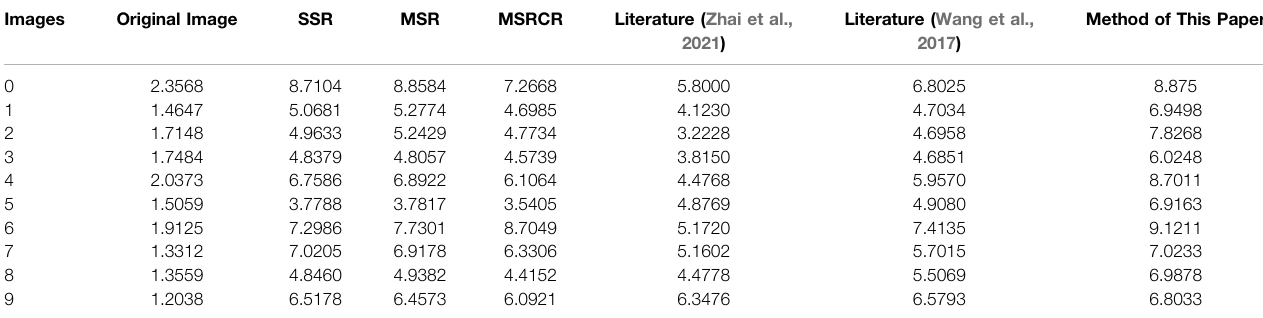
TABLE 5 | AG of low-illumination image enhancement with different algorithms. Images Original Image